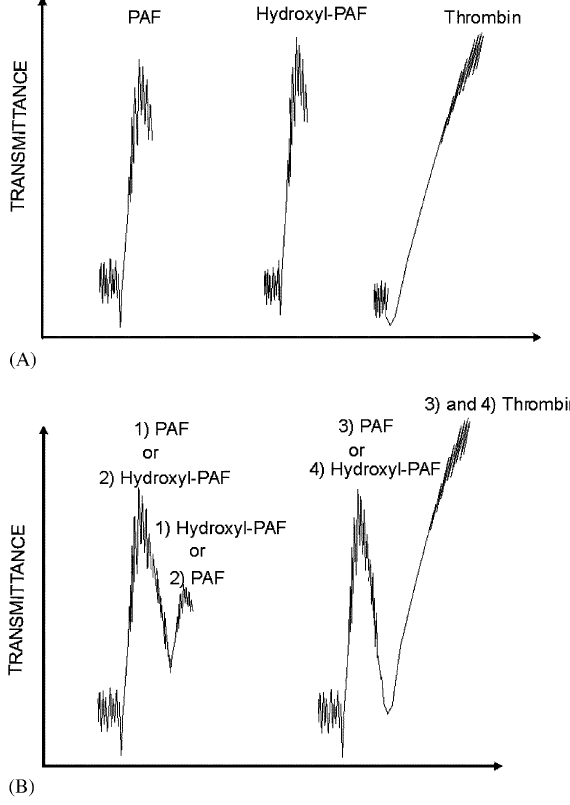
FIG. 2. (A) Reversible washed rabbit platelet aggregation curves induced by semi-synthetic PAF and by the hydroxyl- PAF analogue isolated from blood, and the irreversible washed rabbit platelet aggregation curve induced by throm- bin. (B) Desensitization experiments with washed rabbit platelets: (1) PAF against hydroxyl-PAF analogue; (2) hydro- xyl-PAF analogue against PAF; (3) PAF against thrombin; (4) hydroxyl-PAF analogue against